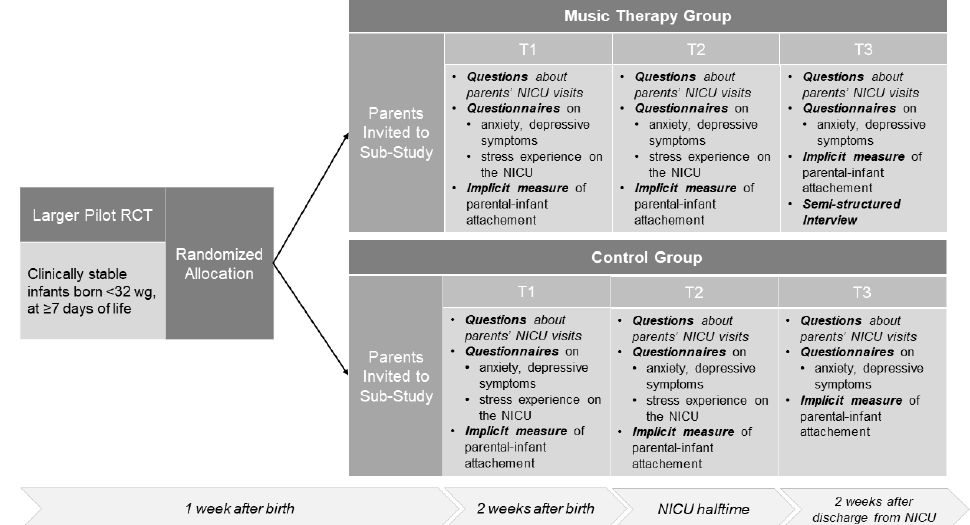
Figure 1. Study design and procedure. Wg = weeks of gestation.